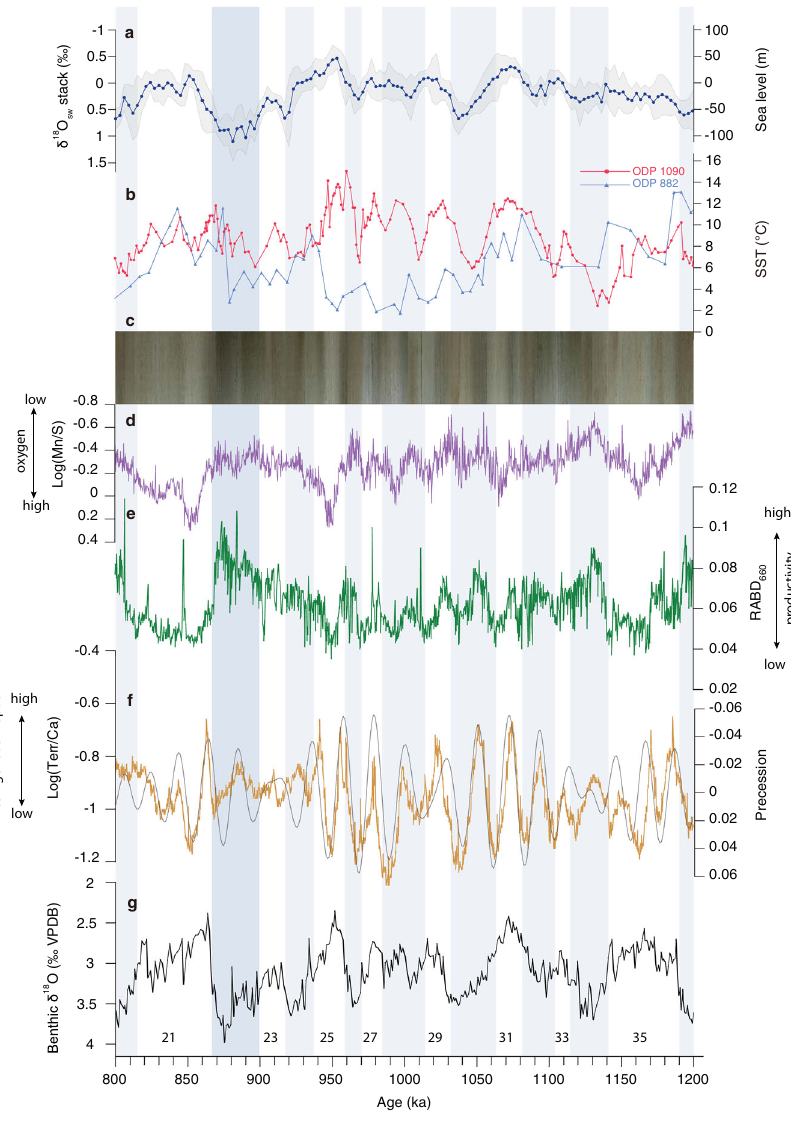
Fig. 4 | Evolution of NW Australian climate across the Middle Pleistocene Transition. a Sea-level reconstruction based on seawater δ 18 O ( δ 18 O sw ) stack (with 1 σ errorenvelope)fromref.67. b High-latitudeNHandSHseasurfacetemperature (SST)records,red:SSTrecordfromODPSite1090insubantarcticAtlanticOcean 47 (42°54.8 ’ S, 8°53.9 ’ E), blue: SST record from ODP Site 882 in subarctic Paci fi c